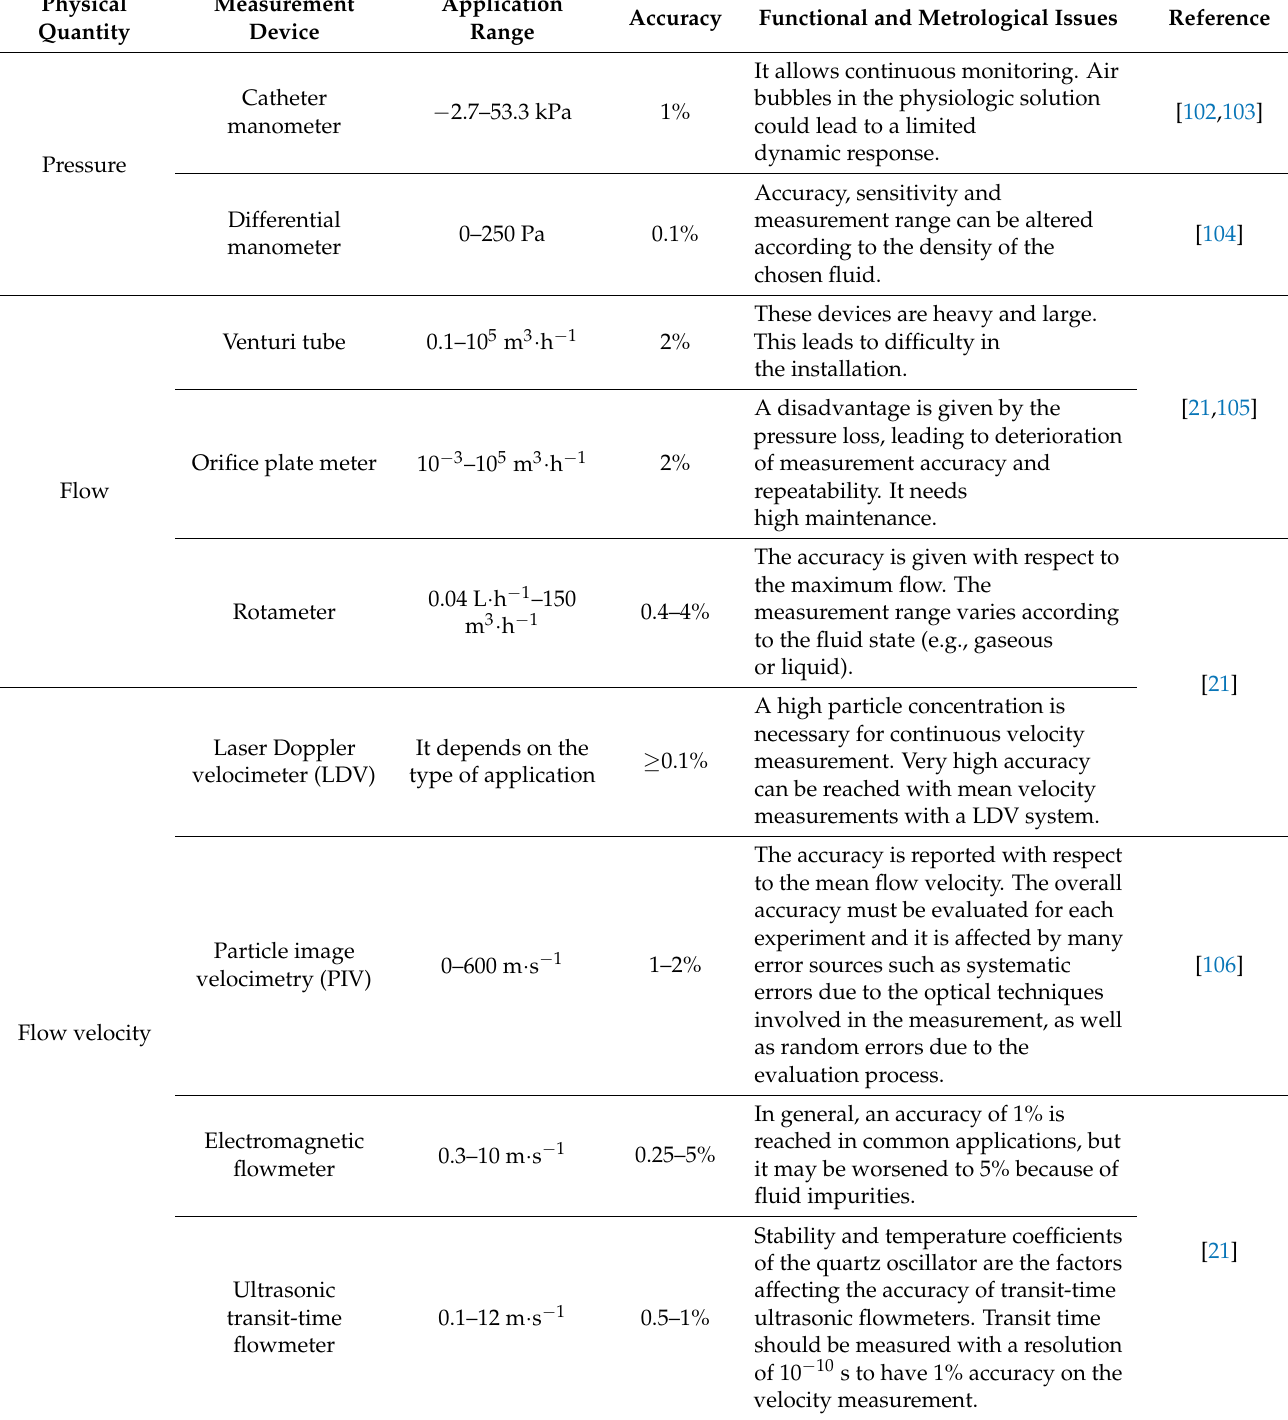
Table 1. Overview of devices commonly used for the measurement of physical quantities in arte- rial